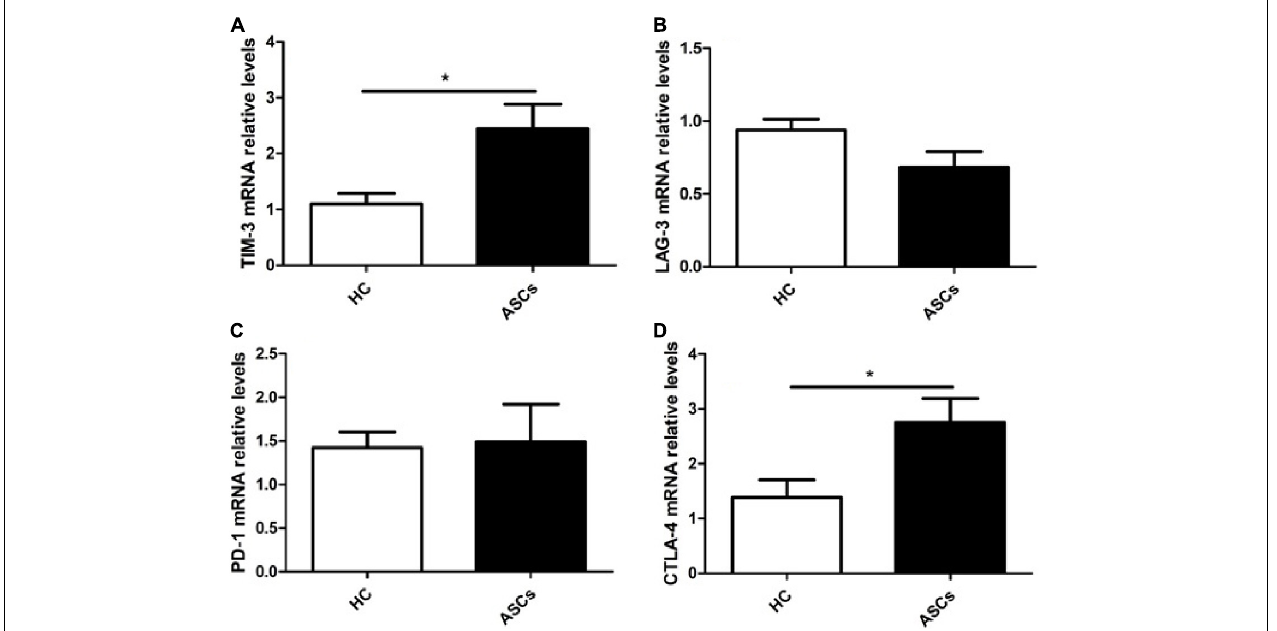
FIGURE 5 | Expression levels of immune checkpoint molecules mRNA in PBMCs from chronic ASCs. (A) The relative levels of TIM-3 mRNA. (B) The relative levels of LAG-3 mRNA. (C) The relative levels of PD-1 mRNA. (D) The relative levels of CTLA-4. HC: n = 6, ASCs: n = 9. Data represent the mean ± SEM. * P < 0.05.